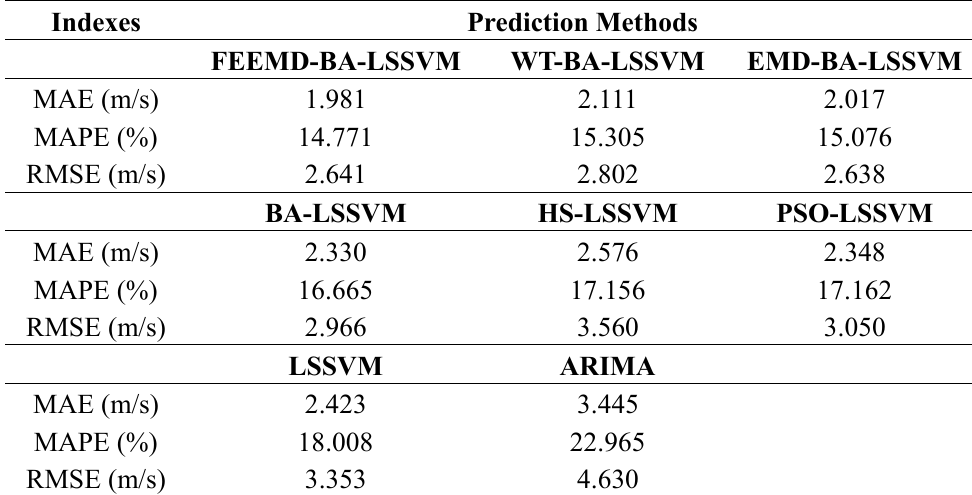
Table 8. Analysis of the predictions without temperature as